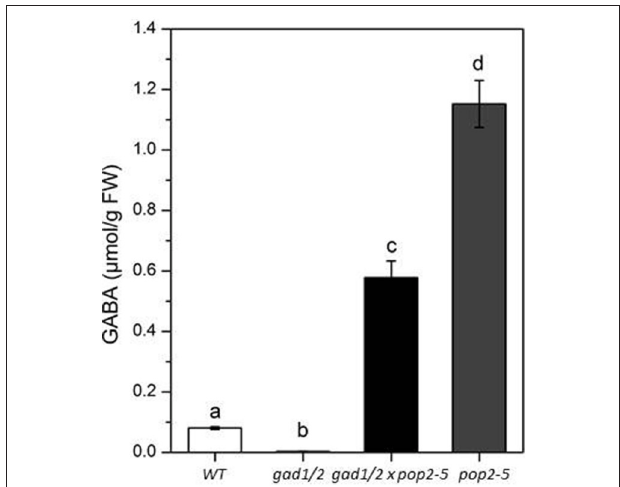
FIGURE 2 | GABA amounts of 4-week-old wild-type (WT), gad1/2 , gad1/2 x pop2-5 , and pop2-5 plants. All plants were grown under greenhouse conditions and GABA was quantified in leafs. Values are means of eight independent plants. Error bars represent the standard error of means. Statistically significant differences between WT and GABA mutant plants were analyzed by One-way ANOVA ( p < 0.05 , SNK-test) and are indicated by different